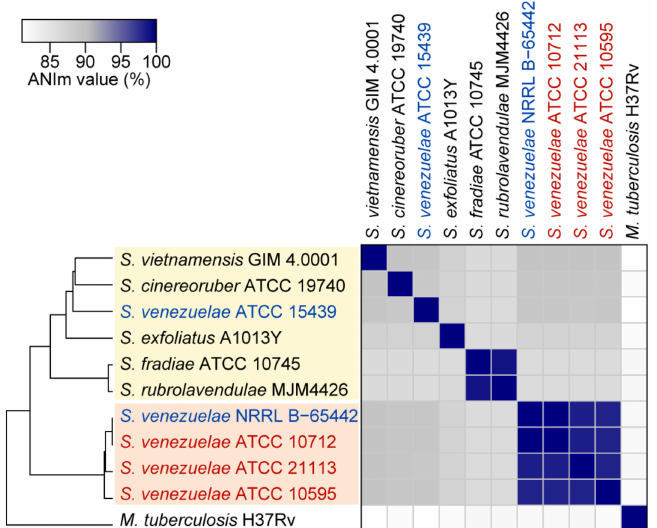
Figure 3. The average nucleotide identity values based on MUMmer algorithm (ANIm) between S. venezuelae strains and other Streptomyces species. The four closely related S. venezuelae strains (ATCC 10712, NRRL B-5442, ATCC 21113, and ATCC 10595) are in the orange box. The strains that were clustered with S. venezuelae ATCC 15439 are in the yellow box. In particular, S. venezuelae strains whose genome sequences were completed in this study are represented as red, and the other S. venezuelae strains are represented as blue. Mycobacterium tuberculosis H37Rv was used to show the phylogenetic distance with other